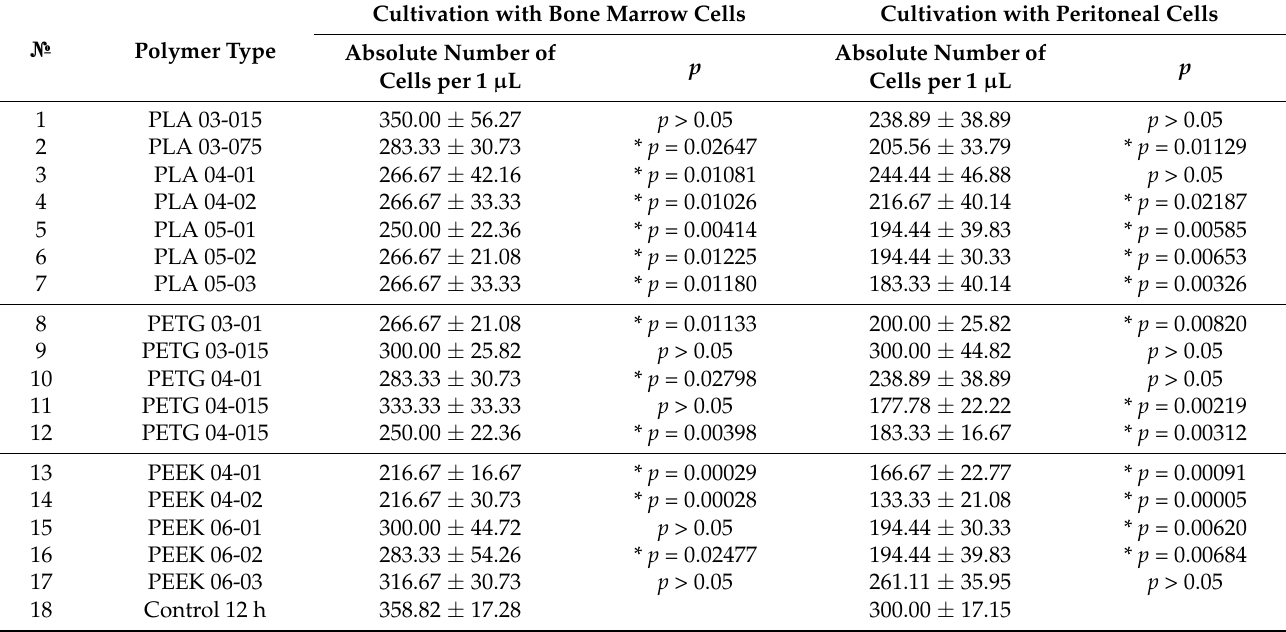
Table 4. Absolute number of cells after 12-h cultivation with polymer